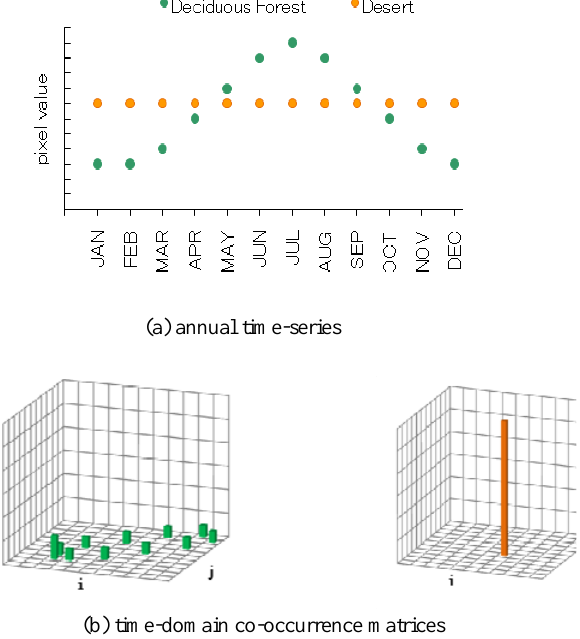
Figure 3. Conceptual examples of time-domain co- occurrence matrix.